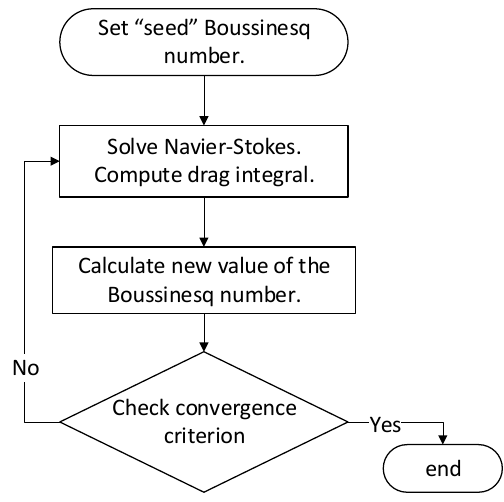
Figure 1. Data analysis scheme